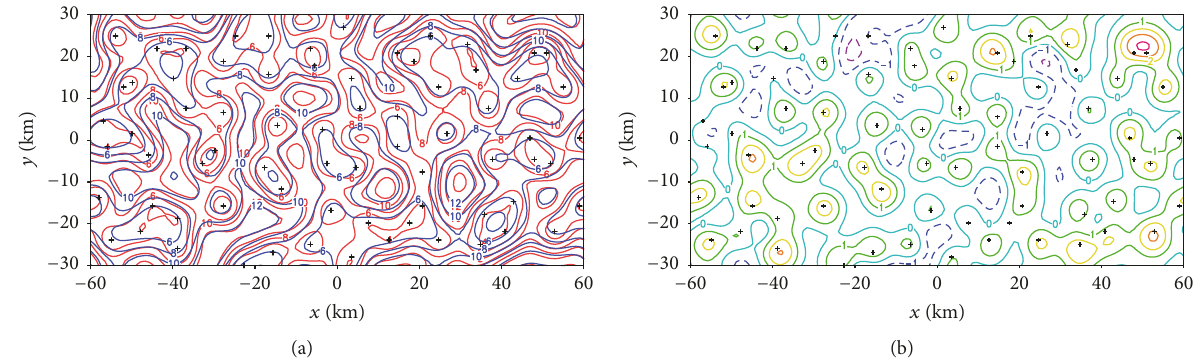
Figure 11: As in Figure 10 but for the second set of innovations with nonuniformly distributed coarse-resolution observations, and the colored contours are plotted every 1m 2 s −2 for the deviation of 𝜎 2 𝑎 ∗ ( x ) from 𝜎 2 𝑎 ( x ) in panel (b).